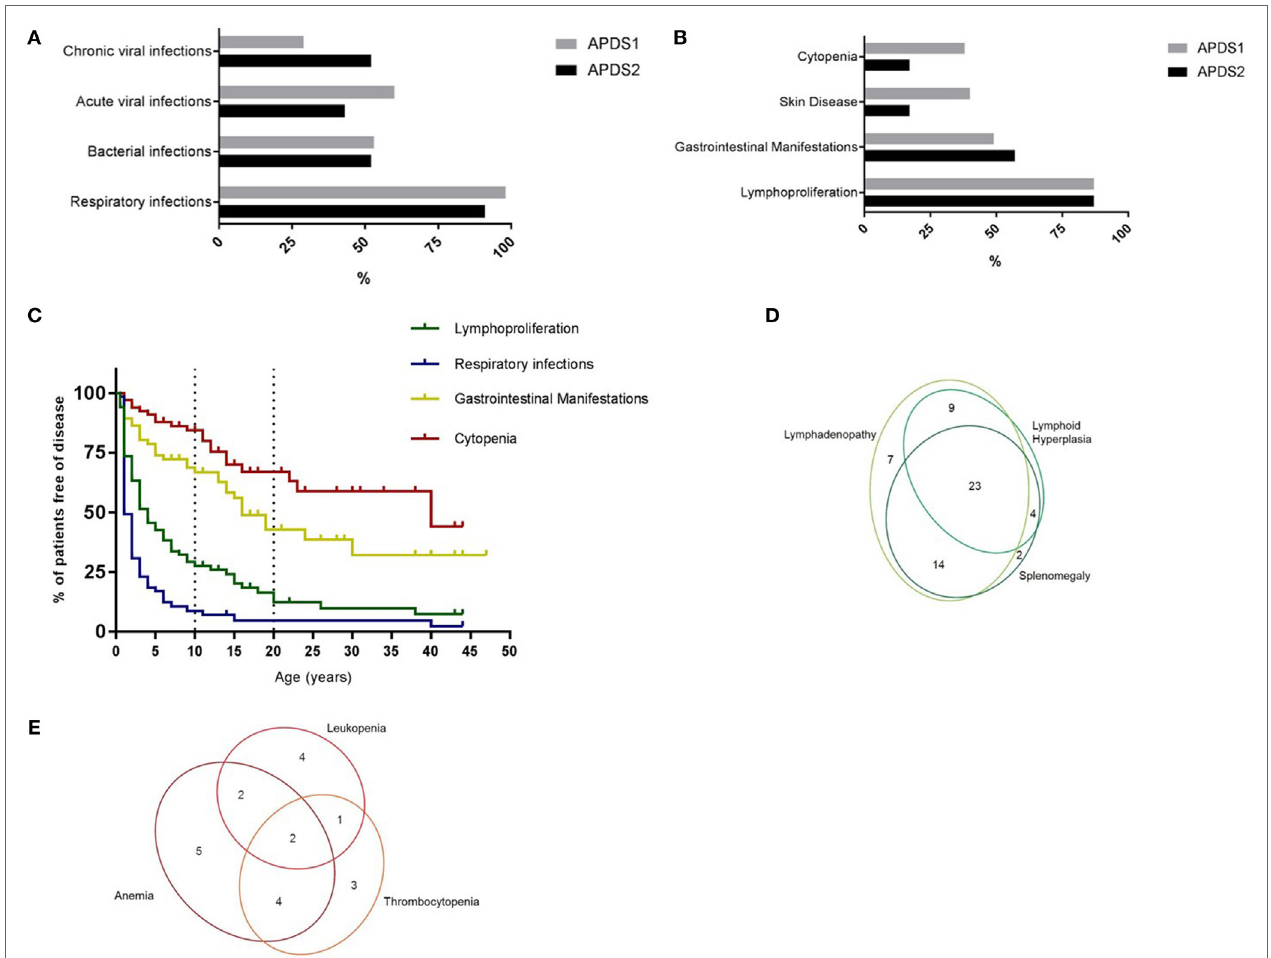
FiGUre 1 | (A) Incidence of infections in APDS1 and APDS2 patients. (B) Incidence of manifestations of immune dysregulation in APDS1 and APDS2 patients. (c) Evolution of disease manifestations over time. Information regarding age at onset available for: respiratory infections n = 62/65, lymphoproliferation n = 59/59, gastrointestinal manifestations n = 33/35, cytopenia n = 20/21 patients. (D) Diagram showing the different types of benign lymphoproliferative manifestations. (e) Diagram showing the different blood lineages affected in patients with